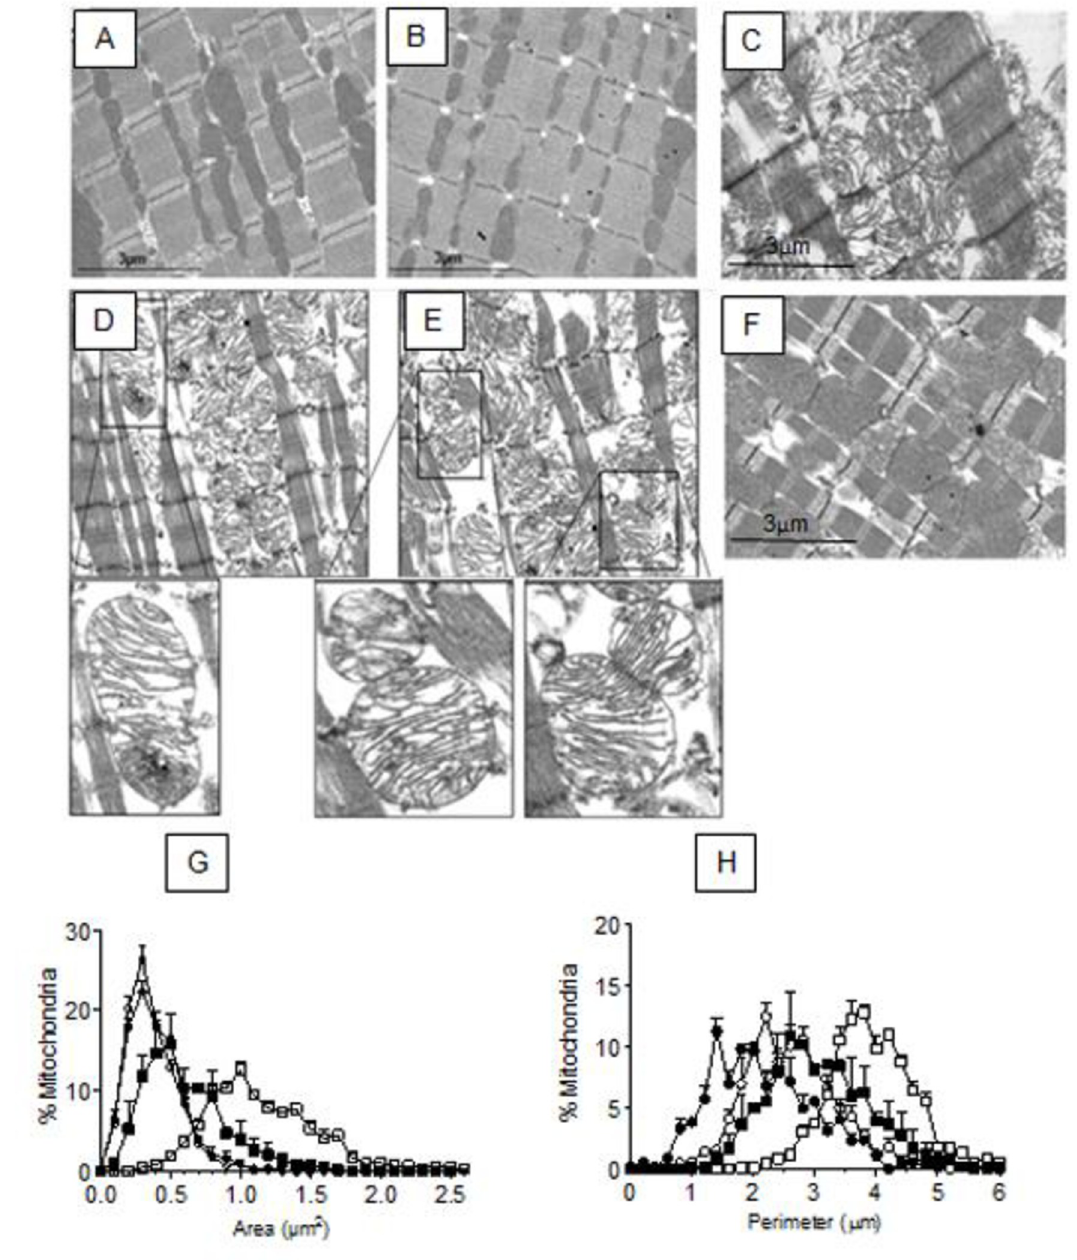
Fig 3. Effect of ixazomib on mitochondrial morphology in ischemic hearts. Transmission electron microscope images of (A) a control heart, (B) a control heart perfused with IXA, (C) a heart subjected to ischemia. (D and E) are images of an ischemic heart captured with a high-resolution scanning electron microscopy. Insets correspond to amplifications of the indicated zones in (D) and (E) showing mitochondrial cristae aberrations such as transversal discontinuity. (F) a heart subjected to ischemia in the presence of IXA (G) Frequency distribution of mitochondrial area and (H) perimeter of mitochondria in each experimental group. Symbols: C, white circles; C+IXA, black circles; I, white squares; I + IXA, black squares. Data on (G) and (H) are the average of 600–800